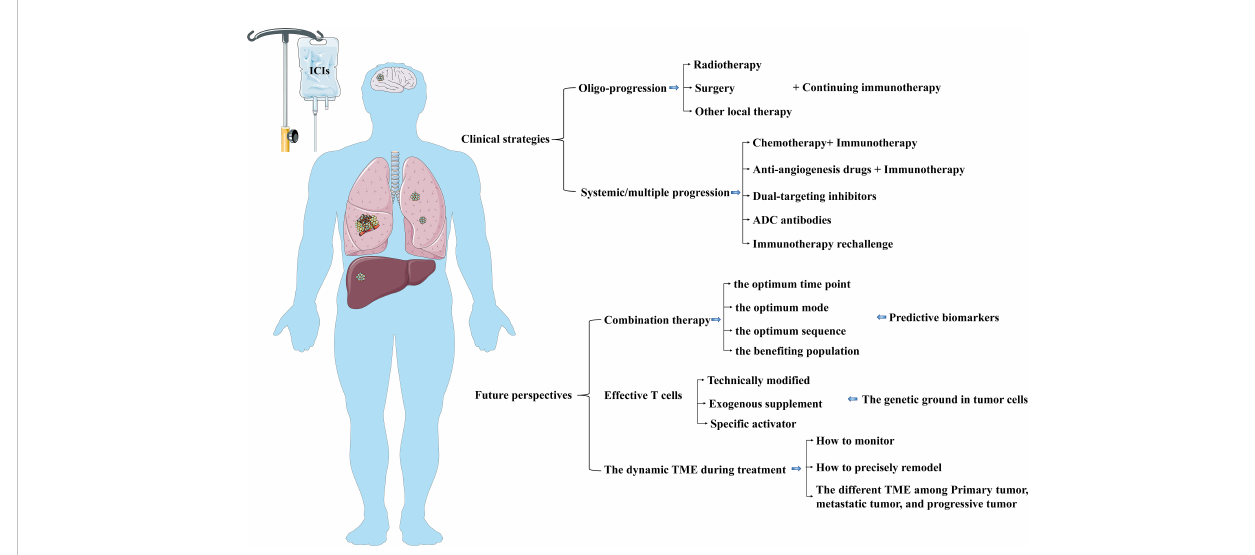
FIGURE 5 The current clinical strategies and future perspectives in NSCLC patients after immunotherapy resistance. The selection of clinical treatment for NSCLC progression after immunotherapy resistance should be dependent on the progressive mode. Further studies can pay attention to optimizing the combined therapy and exploring strategies to modulate in fi ltrating immune cells and timely reshape